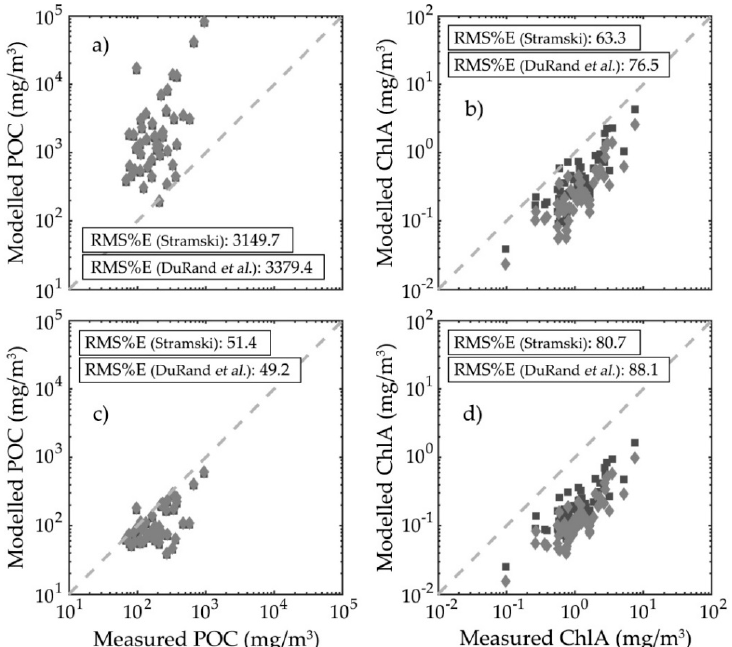
Figure 9. Comparison of ( a ) modelled vs. measured POC and ( b ) modelled vs. measured ChlA when a spherical model of particle volume is employed, and comparison of ( c ) modelled vs. measured POC and ( d ) modelled vs. measured ChlA when a fractal model of particle volume is employed instead. POC and ChlA values calculated using the Stramski [19] and Durand et al. [20] models are represented by dark grey squares and light grey diamonds respectively. The dashed grey lines indicate the 1:1 relationship.